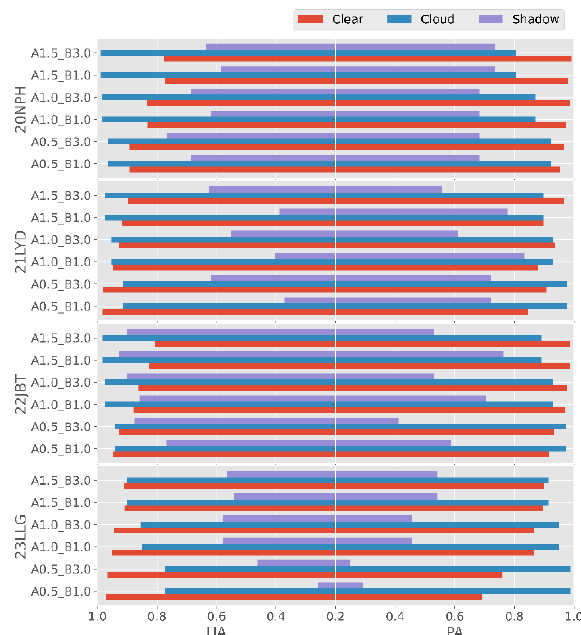
Figure 4 User's accuracy (UA) and Producer's accuracy (PA) for different combinations of A and B parameters value in ATSA algorithm considering three classes: Cloud, Cloud shadow, and Clear.